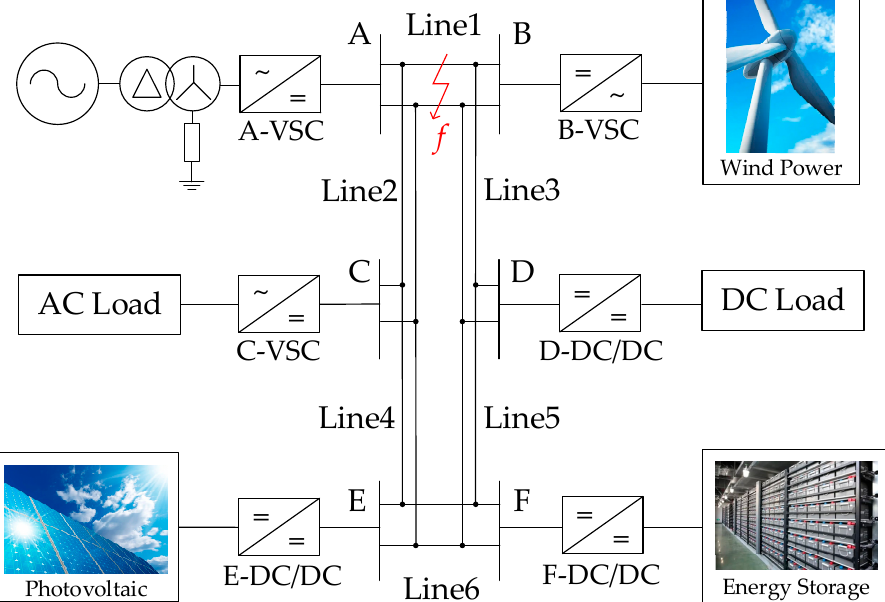
Figure 3. Topology of six-terminal flexible distribution network.